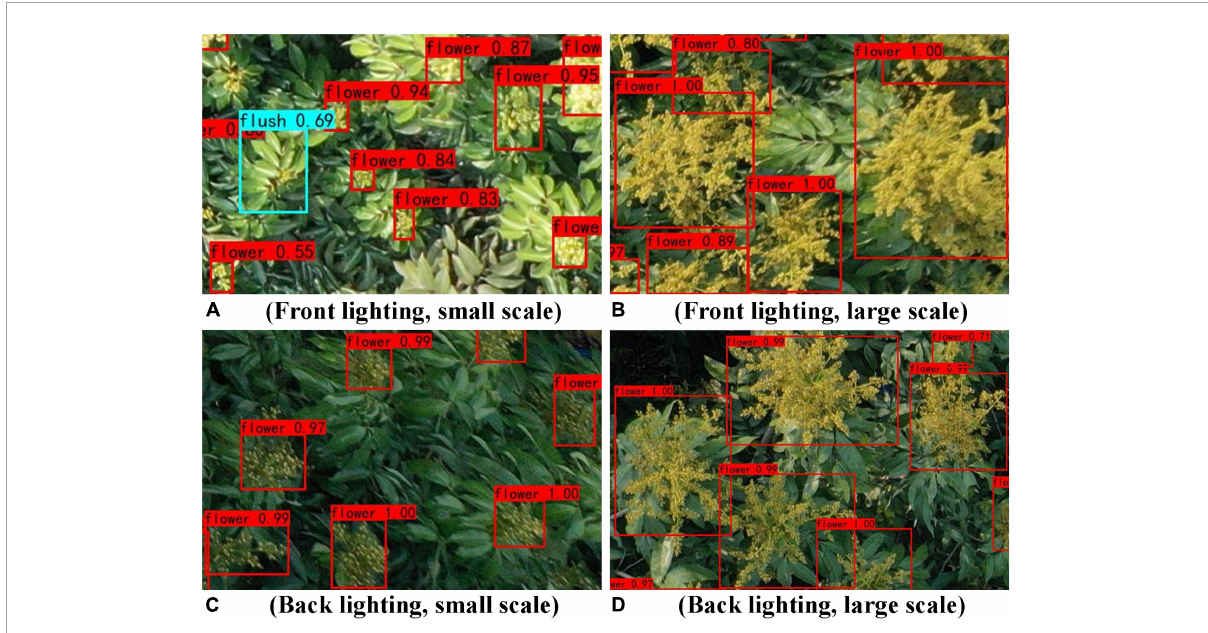
FIGURE9 Results of the YOLOv4 model detection results obtained under different lighting